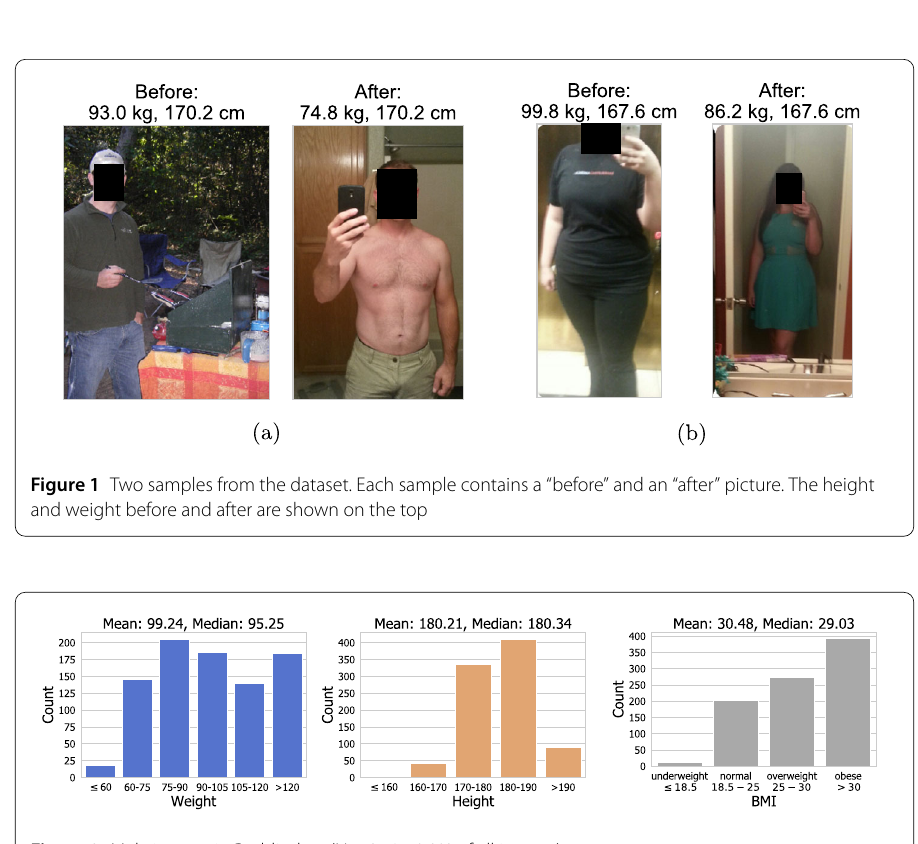
Figure 2 Male images in Reddit data (N = 876, 52.3% of all